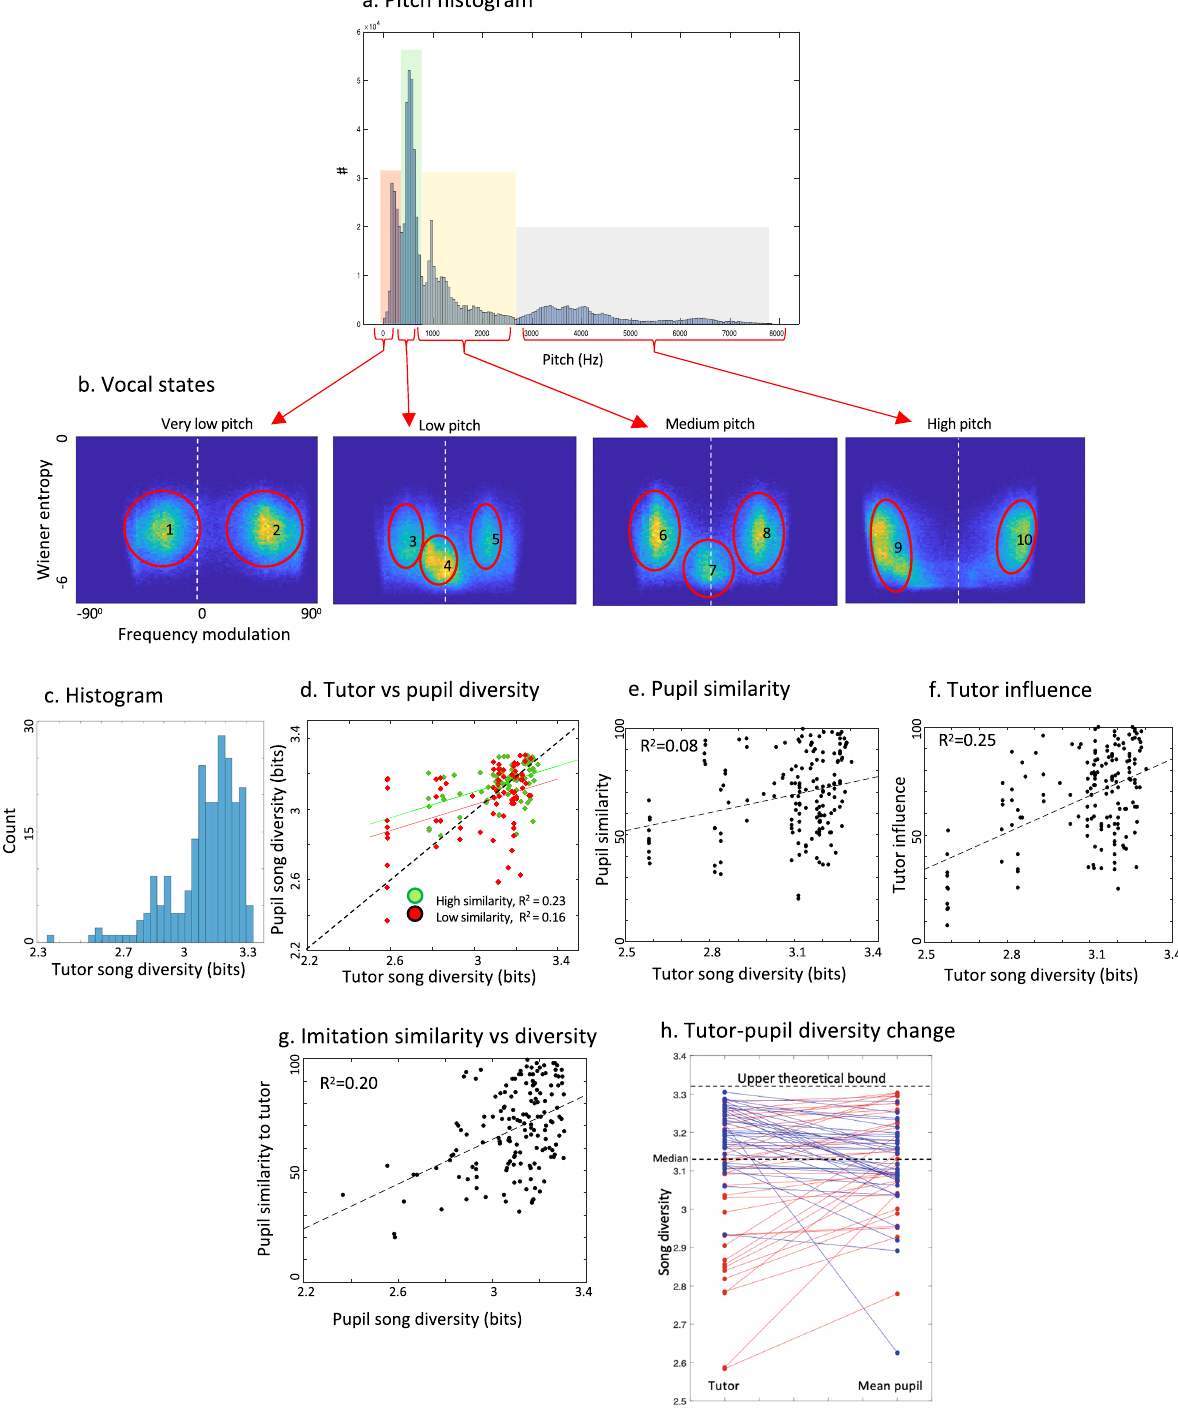
Fig. 4 Vocal states and diversity in zebra fi nch songs. a Histogram of pitch, calculated in 10 ms windows and pooled for all songs 31 . Shadings show partitioning into four regions according to contours of the pitch distribution. b Two-dimensional heatmaps of frequency modulation and Wiener entropy for each of the four-pitch regions. Red circles outline 10 clusters around which vocal states are de fi ned. c Histogram of song diversity for all male birds recorded. d Song diversity in tutor songs versus pupil songs. Colors show R 2 separately for high and low similarity birds. e Tutor song diversities vs. similarity with pupil songs ( R 2 = 0.08, t = 1.9, Linear mixed-effects model NS). f Tutor song diversities vs. the in fl uence of tutor song on pupils ( R 2 = 0.25, Linear mixed-effects model t = 4.8, p = 4.2e − 6). Vertically aligned markers are often birds from the same lineage. The trend remains signi fi cant after removing the lowest diversity families (<2.7, p = 0.003). g Pupil song diversity vs. pupil song similarity to tutors. h Song diversity in families, comparing the songs of tutors versus the mean diversity across all of their pupils ’ songs. The upper dotted line represents the upper theoretical bound where all vocal states are equally abundant. The lower dotted line indicates the median. Blue lines show decreases, and red shows increases in pupil song diversity. Source data for this fi gure is in Supplementary Data File